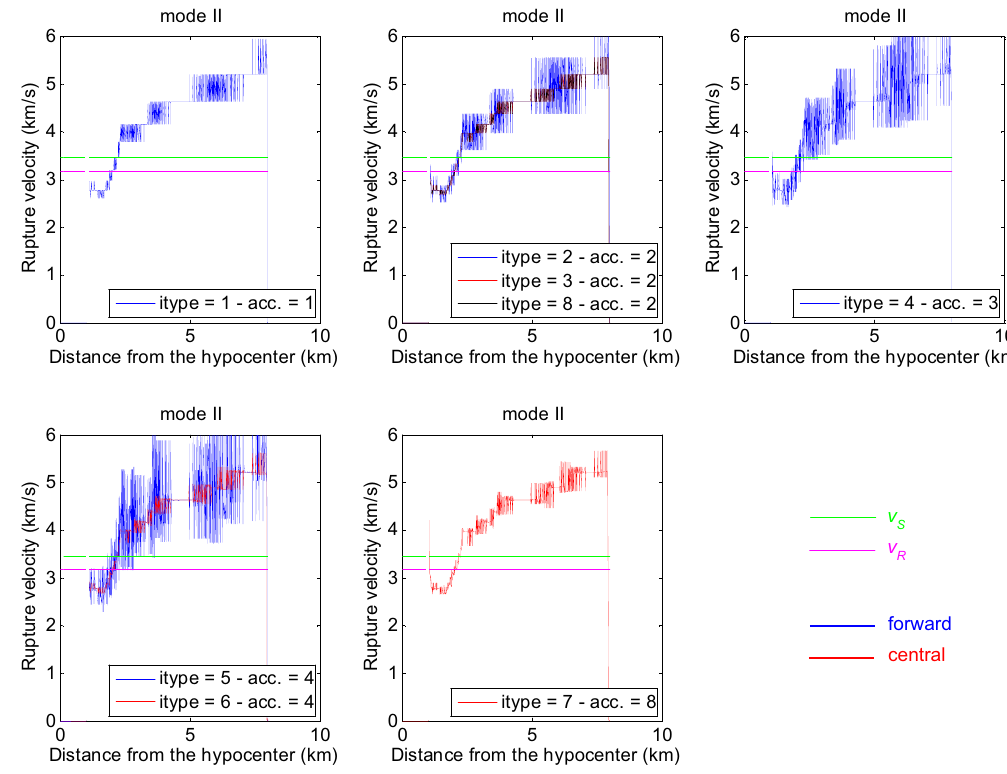
Figure 2. Comparison between different numerical computations of the rupture speed, as described in the main text (see Section 2.1). The profile is taken at the hypocentral depth and parallel to the strike direction (therefore the propagation is basically mode II). Blue and red curves refer to forward and central schemes, respectively. The legends report the type of the schemes, as listed in Table 2. For a better comparison, each plot reports numerical schemes having the same level of accuracy. Values of v spectively. The parameters are those listed in Table 1.